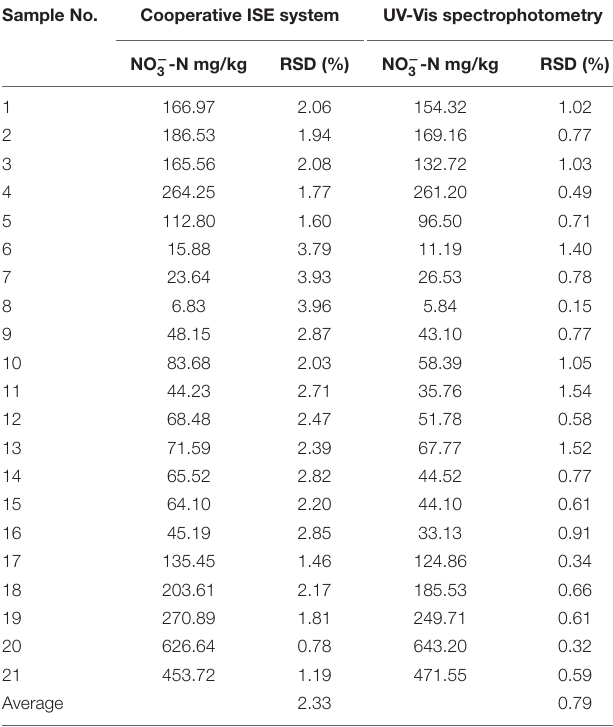
TABLE 3 | Contrast analysis between the cooperative ISE system and UV-Vis spectrophotometry. Sample No.